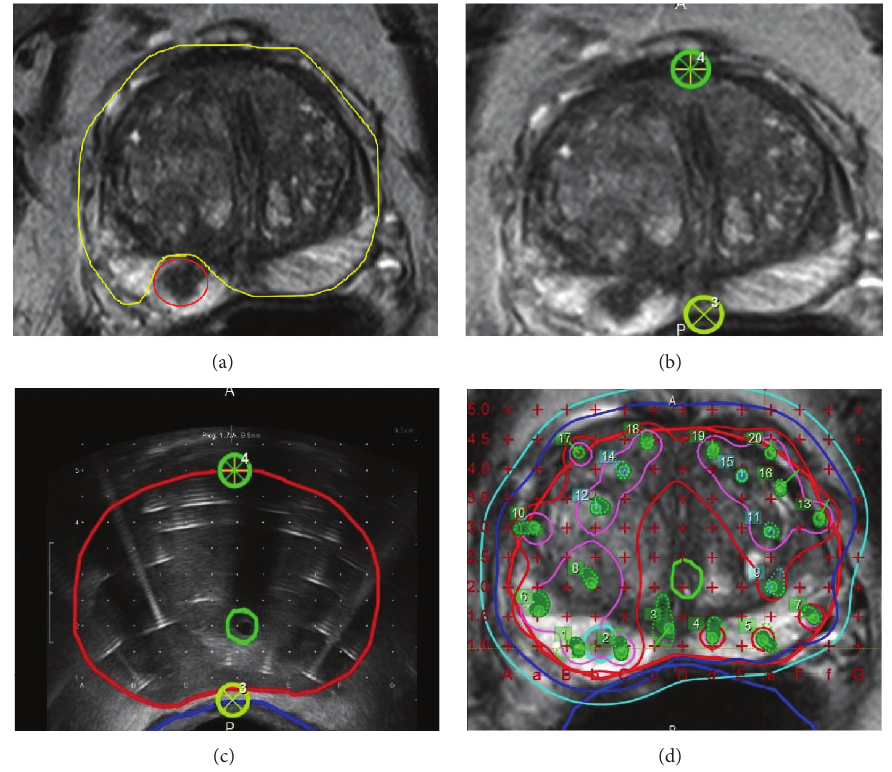
Figure 3: (a) Preprocedural MRI demonstrating GTV (yellow) and nondiseased prostate (red). Preprocedural MRI using two anchor points (green and yellow circles) (b) are able to be registered to intraprocedural TRUS with 2.5 mm grid spacing (c). (d) The resulting merge of the TRUS grid and preprocedural MRI with GTV (thick light blue), urethra (thick solid light green), rectum (thick blue line), and isodose lines (thin lines) for typical whole gland plan using 18 HDR